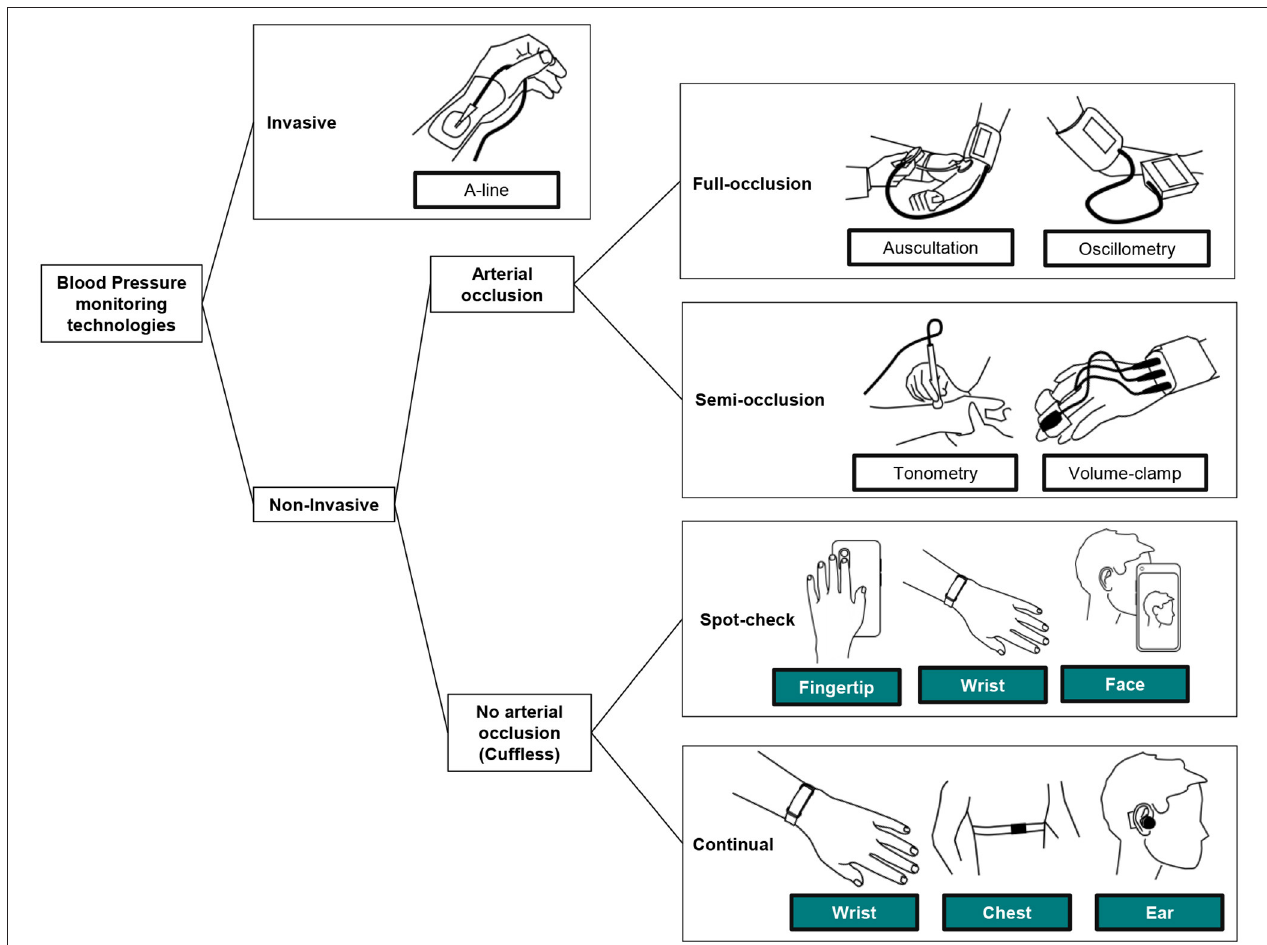
FIGURE 2 | Classification of the BP monitoring technologies in clinical use today, and introduction of the perimeter of cuffless BP monitors. While spot-check monitors allow the assessment of BP readings on demand only, continual monitors can measure on demand and continuously on the background during days and nights [adapted from (